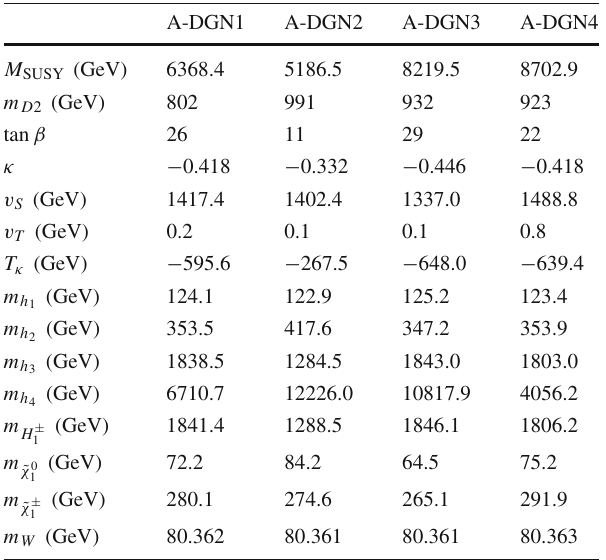
Table4 BenchmarkpointsforthegeneralDGNSSM.Inputparameters are given above the double line, and masses of the most important particles